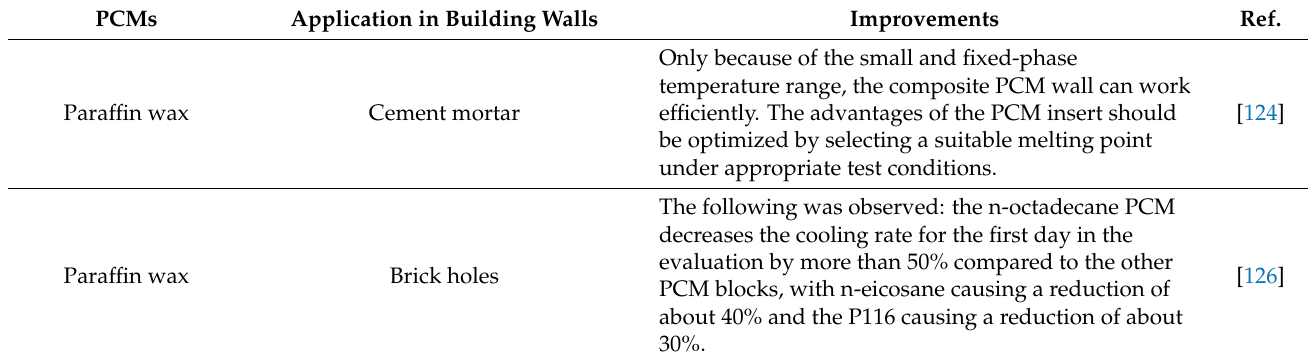
Table 10. Summary of different experimental studies in 2017 from the literature on wall applications.